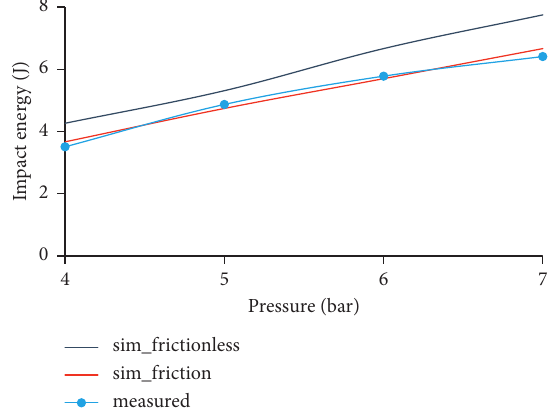
Figure 13: Comparison between measure and simulations of impact